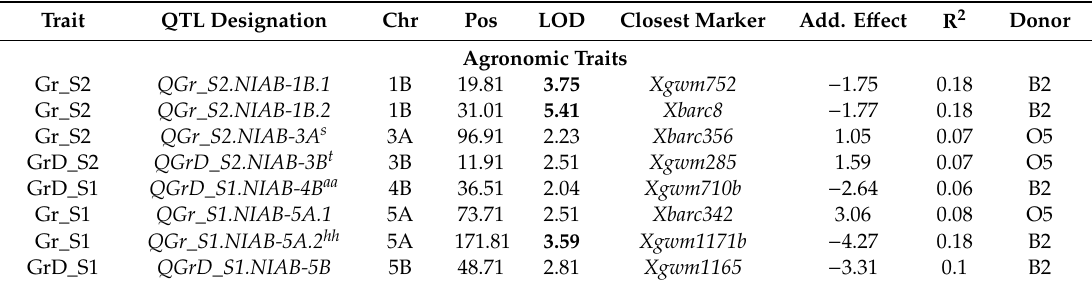
Table 2. Composite interval mapping analysis of the durum wheat RIL mapping population. Highly significant LODs are in bold. QTL with similar superscripts are likely identical